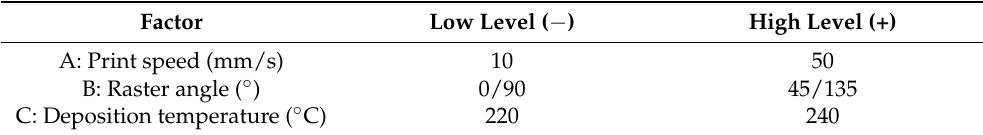
Figure 9. ( a ) Patch printing, with detail ( b ) shown on completed patch. Table 1. Experimental factors and levels.